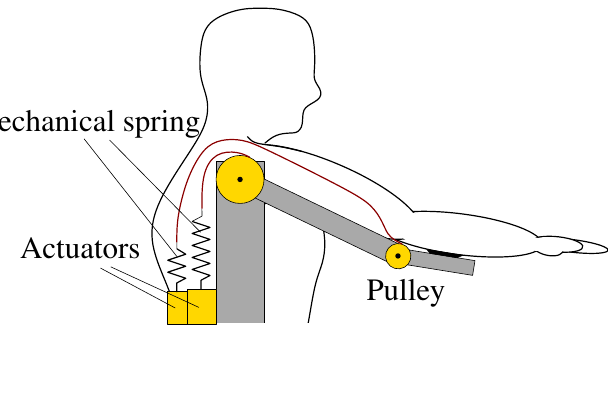
Figure 4. Schematic example of adjustable gravity compensation using mechanical